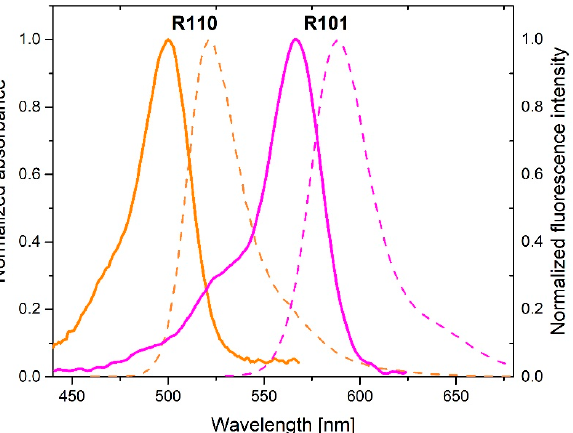
Figure 4. Normalized absorption (solid lines) and emission (dashed lines) spectra of donor (R110) and acceptor (R101). λ exc = 440 nm. Assembly in which molecules are covalently bound to a nanoparticle in a ratio of 1 donor to 350 acceptors is labelled as D TR A, while a structure in which 350 donors falls on 1 acceptor is marked D MIG A. Figure 5a,b present donor fluorescence intensity decays for D MIG A and D TR A systems, bonded covalently to the core-shell surface. Hollow green circles correspond to experi- mental data, blue triangles (Figure 5b) represent results of relevant Monte-Carlo simula- tions and a solid red line (Figure 5b) was plotted based on the theoretical predictions of the FRET model (Equation (2) in this paper).